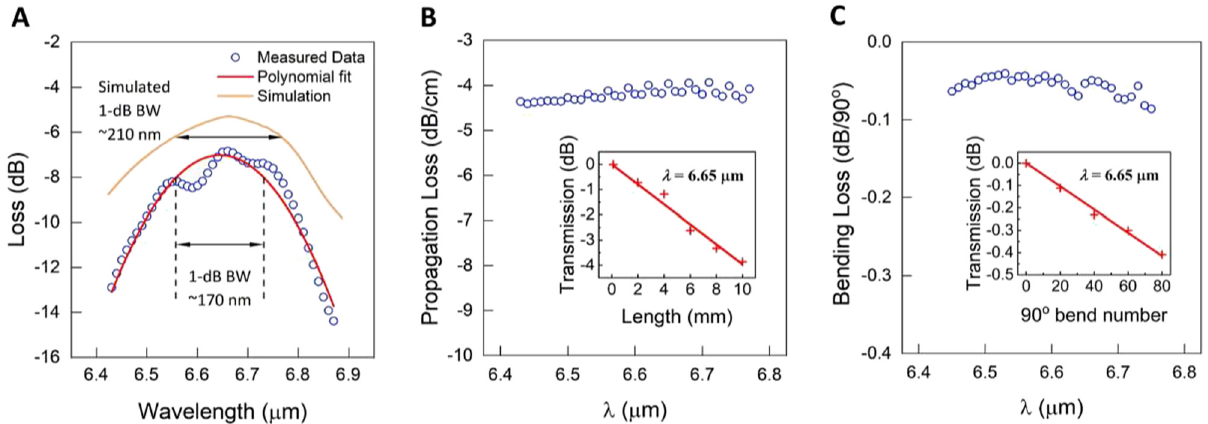
Figure 4: Optical characterization. (A) Simulated and measured coupling efficiency and 1-dB bandwidth of the grating coupler. (B) Propagation loss. Inset: cutback results measured at 6.65 µm; (C) 90 ° bending loss. Inset: cutback results at 6.65